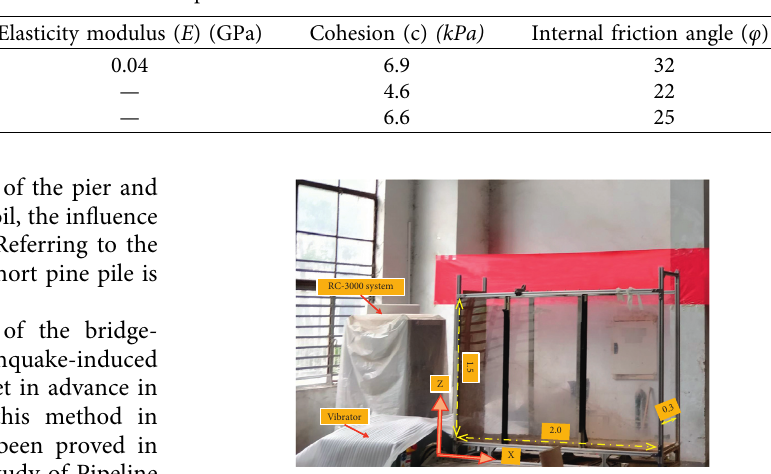
Figure 2: Shaking table test